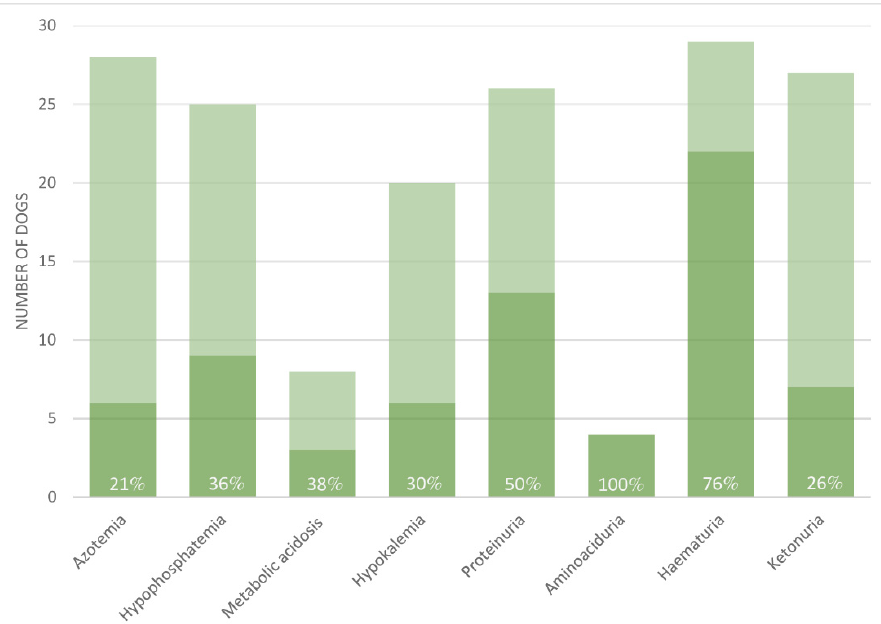
Figure 3 . Para-clinical findings in 30 dogs diagnosed with jerky induced Fanconi syndrome. Para- clinical findings reported in medical records from attending veterinarians for 30 dogs diagnosed with acquired Fanconi syndrome associated with ingestion of jerky treats. All dogs were included due to confirmed normoglycemic/hypoglycemic glycosuria. The dark color represents the number of dogs reported positive for the finding in question. The total height of each bar represents the total number of dogs for which the specific para-clinical finding had been investigated. The white numbers provide the percentage of positive